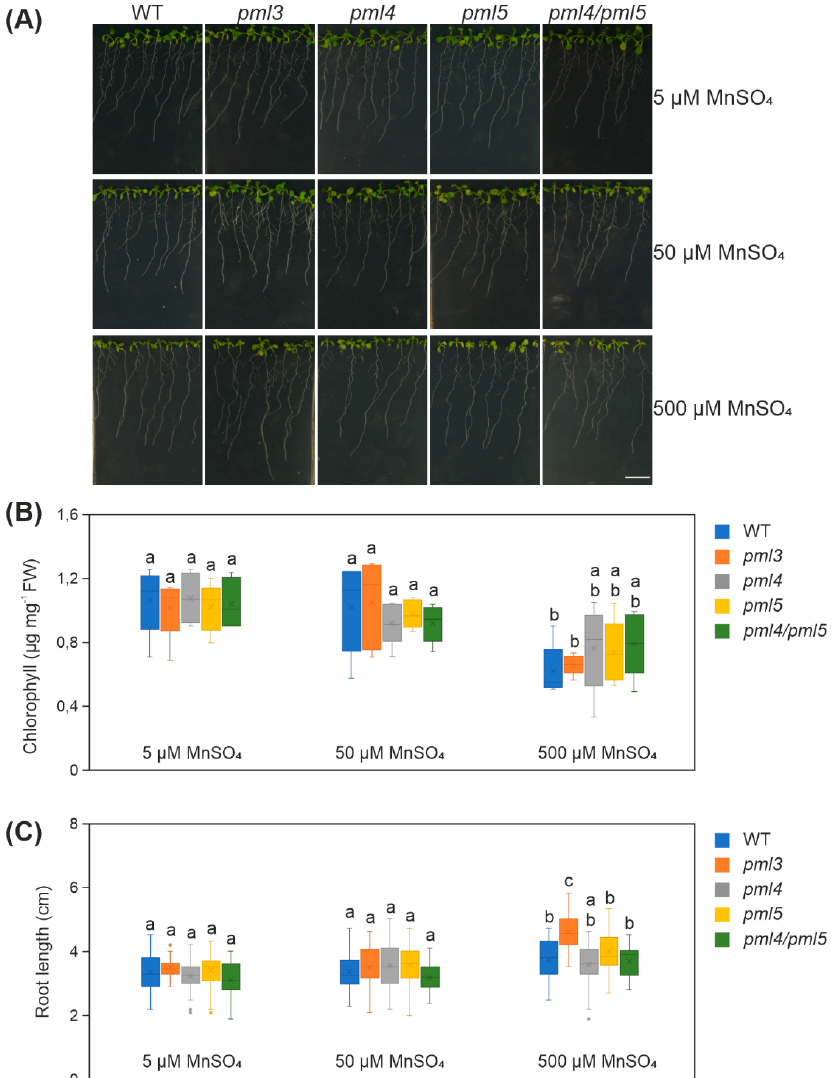
Figure 5. Analysis of wild-type, pml3 , pml4 , pml5 and pml4/pml5 grown under different Mn regimes ( A ) Photographs were taken from representative samples. Plants were grown in the indicated Mn condition, in a vertical position under a 16 h/8 h light–dark cycle at 100 µmol photons m -2 s -1 for 10 days. Scale bar = 1 cm ( B ) Five to six plants per genotype and condition were combined for one chlorophyll extraction and at least five extractions were prepared. Data are depicted as boxplots representing the range of values, the exclusive median and the mean, indicated as x ( n ≥ 5). FW = fresh weight. ( C ) The length of the primary root of all plants are depicted as boxplots representing the range of values, the exclusive median and mean, indicated as x ( n ≥ 35 per genotype and condition). Outliers are indicated as dots. ( B , C ): different letters indicate statistical significance according to ANOVA ( p < 0.05, Tukey’s honestly significant difference (HSD) test). Mean values and standard deviations are given in Tables S2 and S3. Poorly germinated seeds were excluded from the analysis.